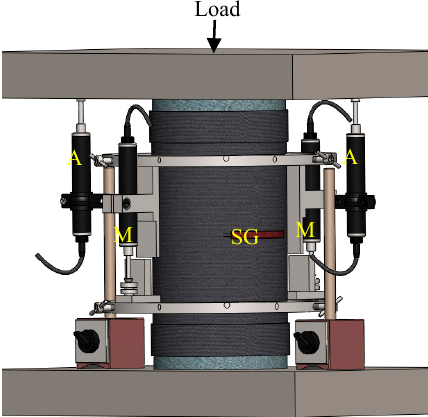
Figure 1. Test setup illustrating LVDT and strain gauge applications (M: Mid-height LVDT; A: All-height LVDT; SG: Strain gauge).